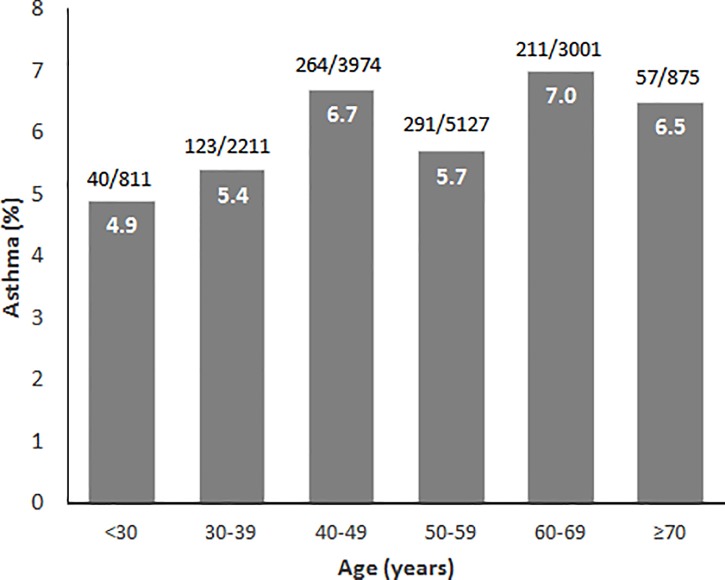
Prevalence of erosive esophagitis according to age.Prevalence of erosive esophagitis showed slightly increasing trend along with age.